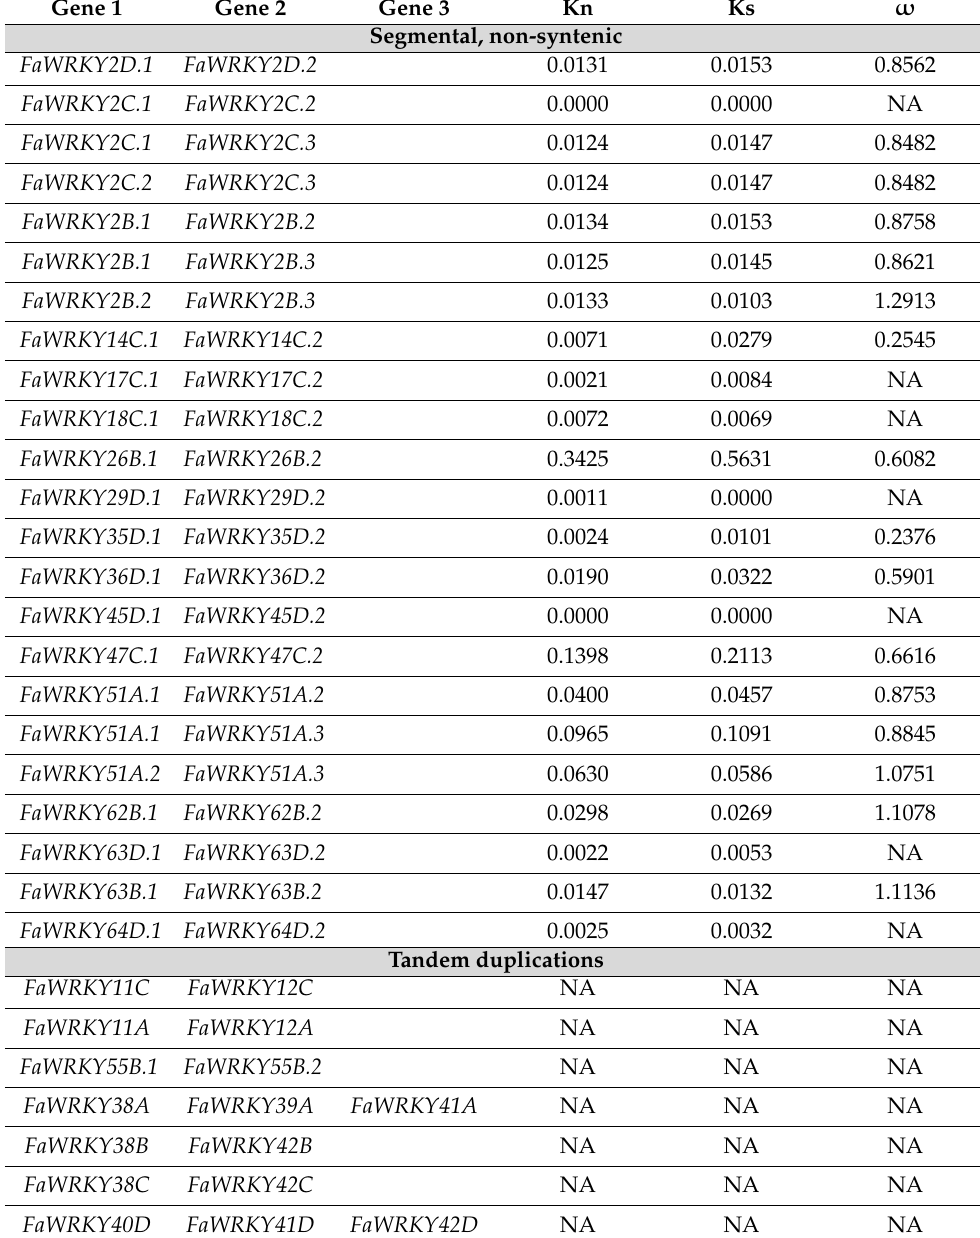
Table 2. Cont. Gene 1 Gene 2 Gene 3 Kn Ks ω Segmental,